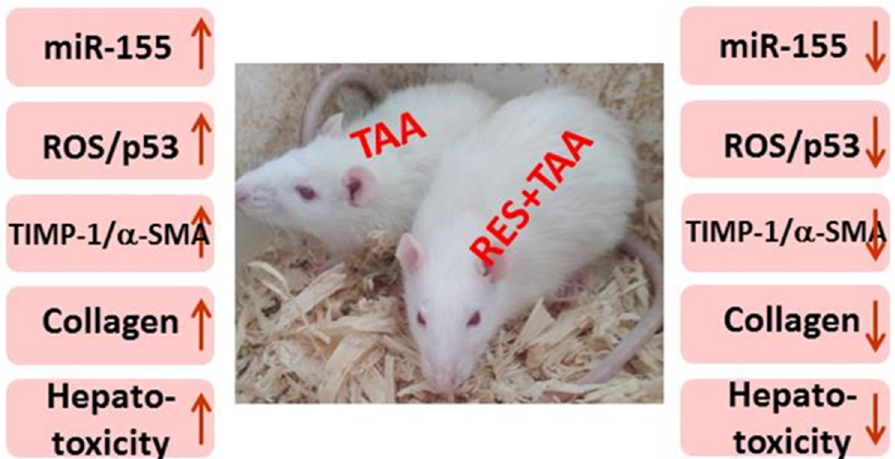
Figure 5. Proposed model for TAA induced miR-155/ROS/p53 axis mediated liver fibrosis appears protected by resveratrol. miR-155: microRNA-155; MDA: malondialdehyde; p53: tumour suppres- sor p53; TIMP-1: tissue inhibitor of metalloproteinases-1; α -SMA: alpha smooth muscle actin.